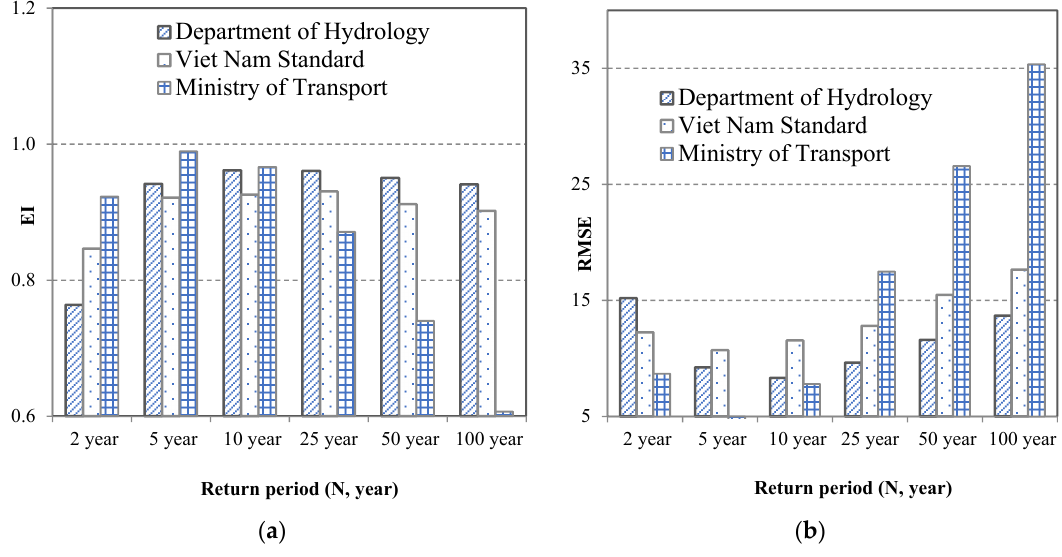
Figure 10. Comparation of the EI index ( a ) and RMSE index ( b ) among empirical formulas.